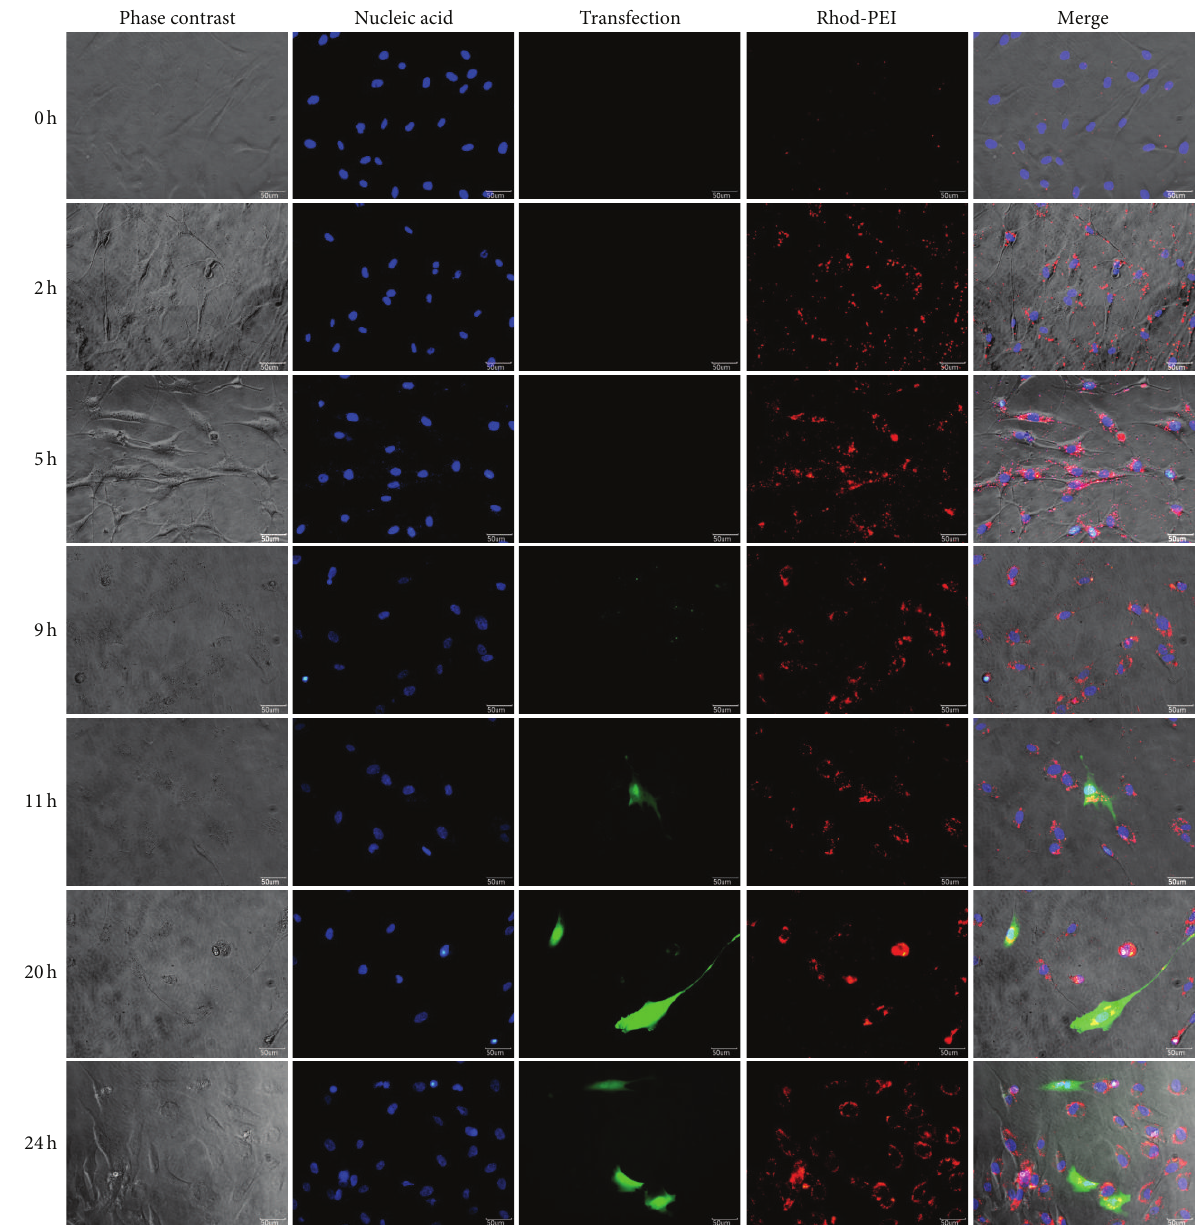
Figure 6: Intracellular expression of EGFP and Rhod-PEI in hTMSCs treated with DNA-PEI NPs at an N/P charge ratio of 8. Time-dependent images of the intracellular expression of EGFP and Rhod-PEI were captured immediately after treating the cells with DNA-PEI NPs. EGFP shows green fluorescence, Hoechst 33342-stained nuclei show bluefluorescence, and Rhod-PEI shows red fluorescence. Magnification is × 400 and the scale bar represents 50 𝜇